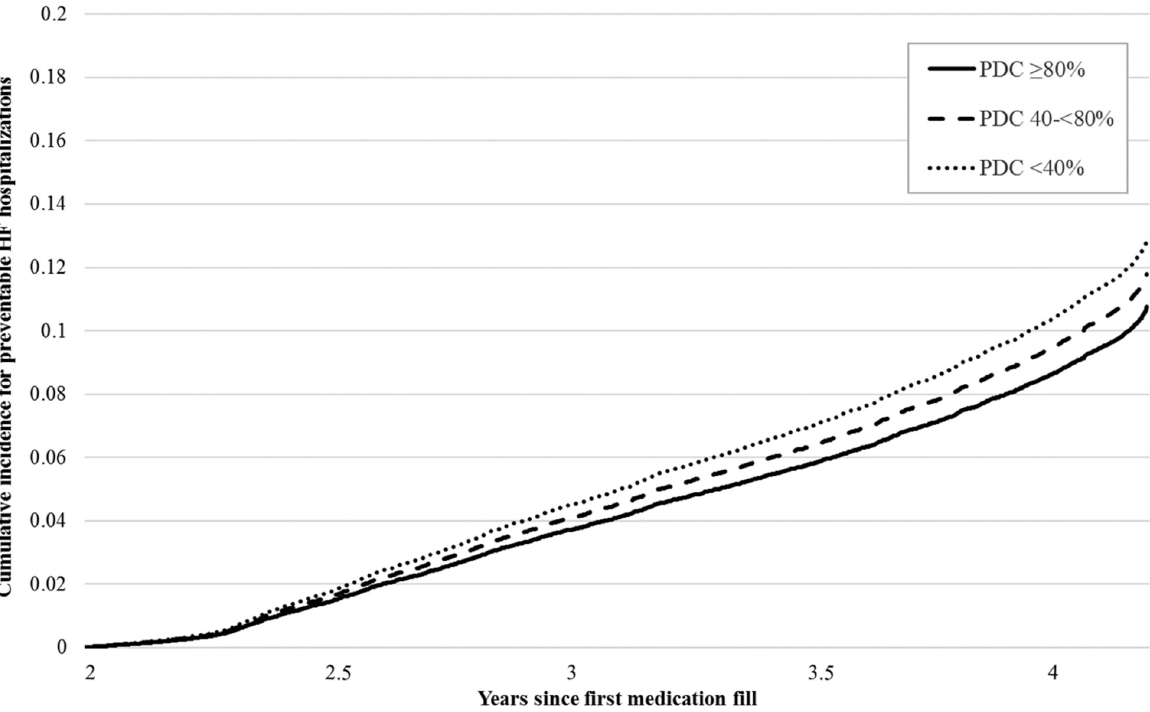
Fig 3. Adjusted cumulative incidence for preventable HF hospitalizations among enrollees at risk for preventable HF hospitalizations, by long-term PDC category, MarketScan 2008–2012 (n =